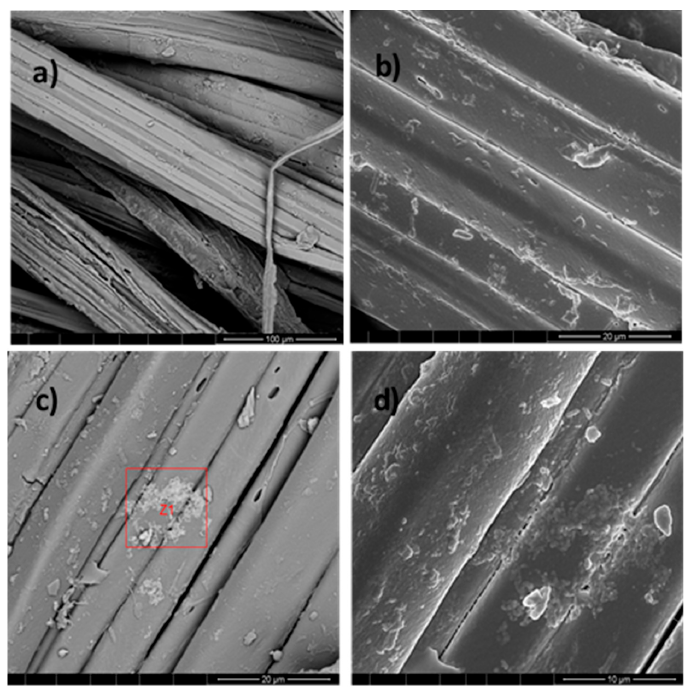
Figure 7. Images of jute fabric impregnated with Ag NPs (sample JPG3) synthesized with PEG, with different magnifications: ( a ) 100 µm, ( b , c ) 20 µm, and ( d ) 10 µm. The ( b , c ) images are in topographic mode, and the Z1 area was used for the EDS analysis.